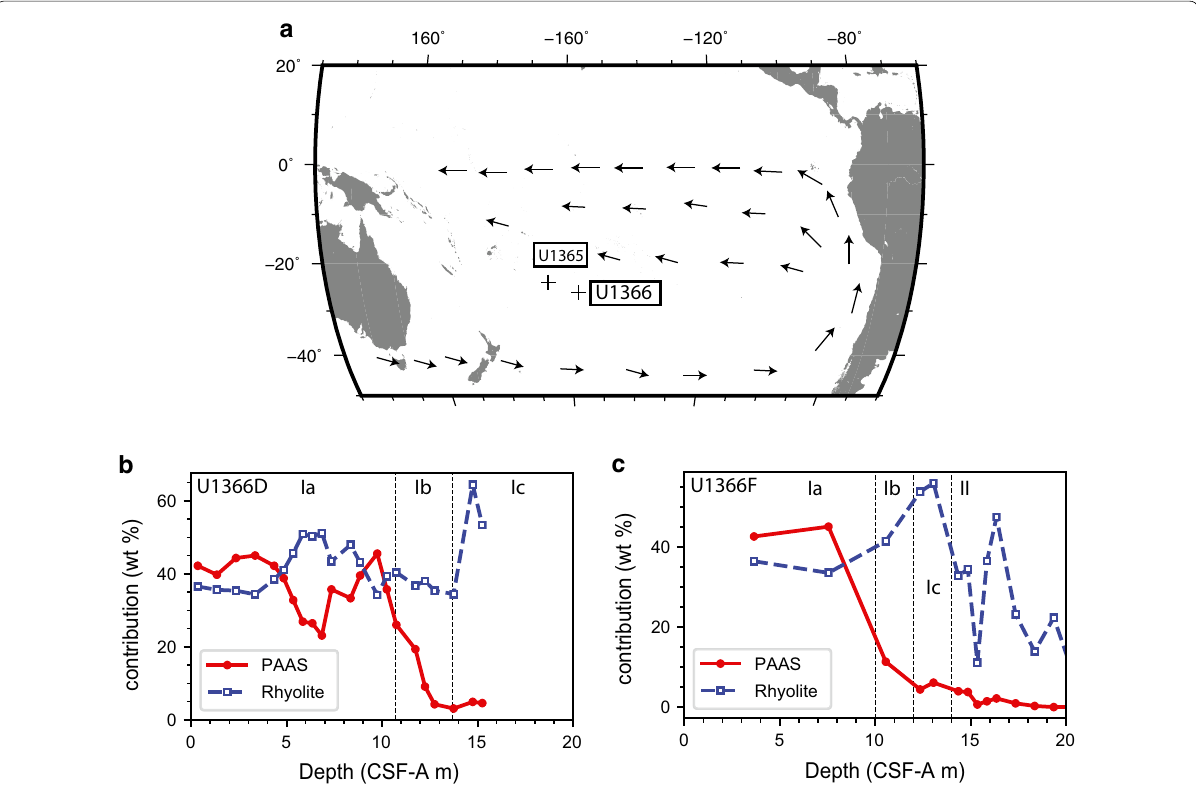
Fig. 1 Site locations and geochemical estimates of the eolian components. a A map showing the locations of Sites U1366 and U1365. Arrows indicate schematic annual average wind directions. b , c Depth variation of the contributions of the eolian geochemical end-members at Hole U1366D ( b ) and Hole U1366F ( c ) (Dunlea et al. 2015a). Red solid circles represent the “PAAS” end-member and blue open squares “rhyolite” end-member. Vertical dashed lines show the location of lithostratigraphic unit